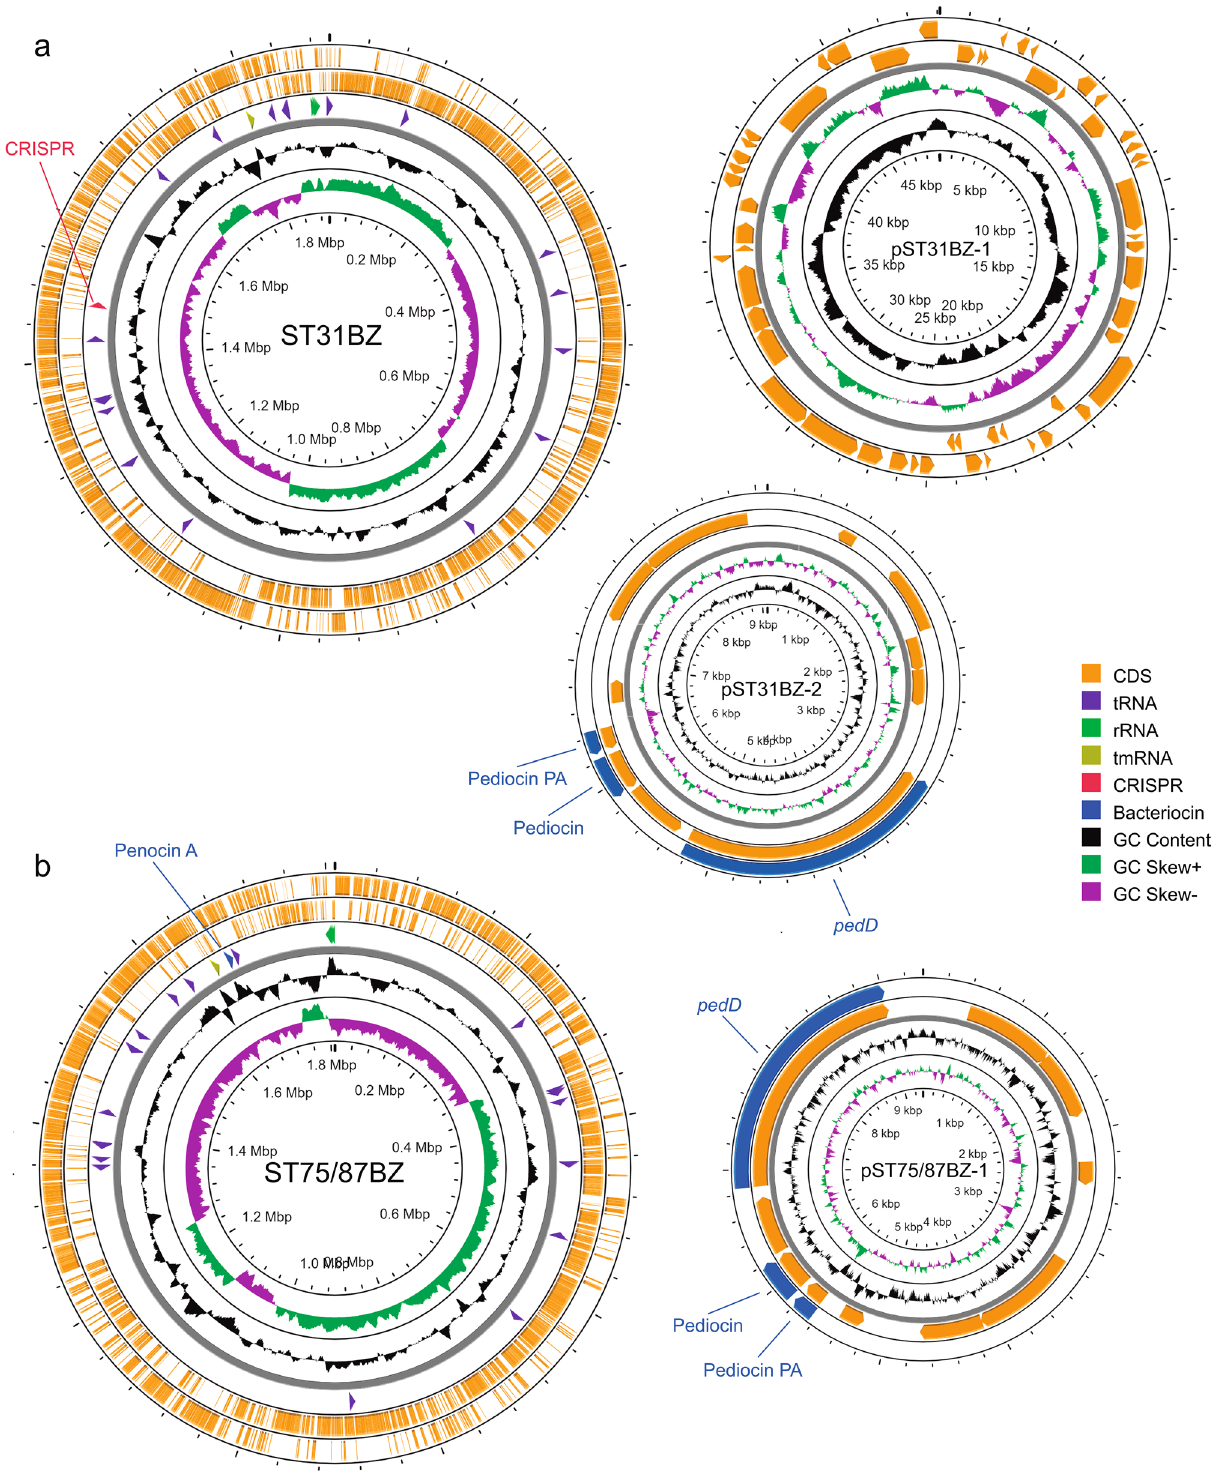
Figure 1. Genome and plasmids from two novel strains of LAB. ( a ) Pediococcus acidilactici ST31BZ and its two plasmids. ( b ) Pediococcus pentosaceus ST75BZ and ST87BZ and its plasmid. Representation is not drawn to scale to allow a good visual representation of the plasmid